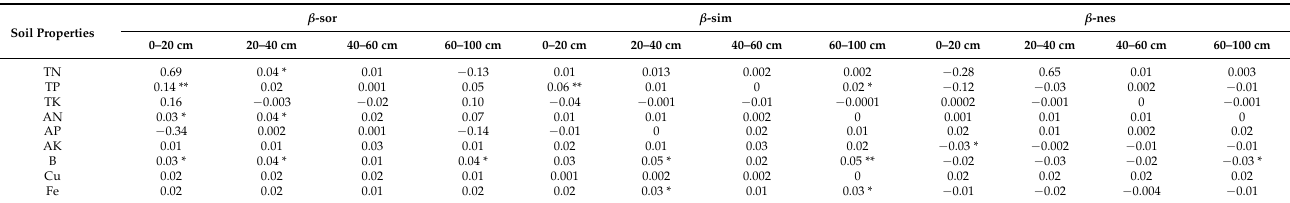
Table 4. The coefficients of Pearson correlation and Mantel test between β -diversity components of herbs and soil factors of different